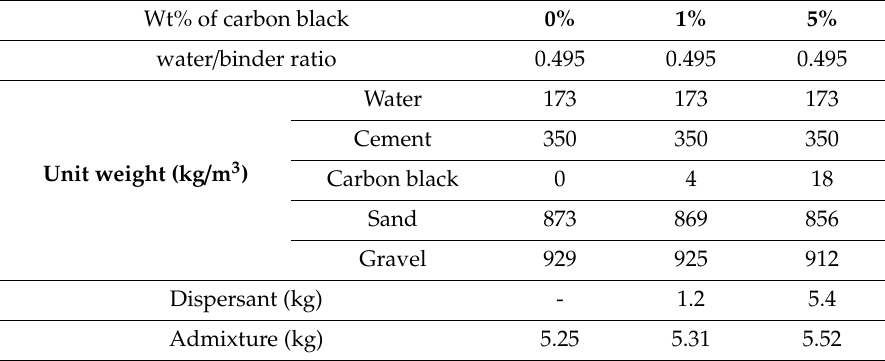
Table 3. Concrete mix